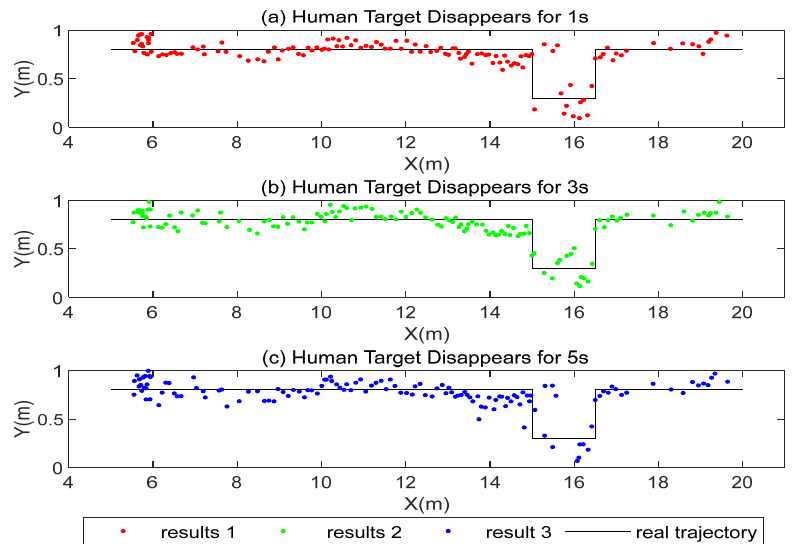
Figure 16. Fusion positioning results with different lengths of time of the human target loss.